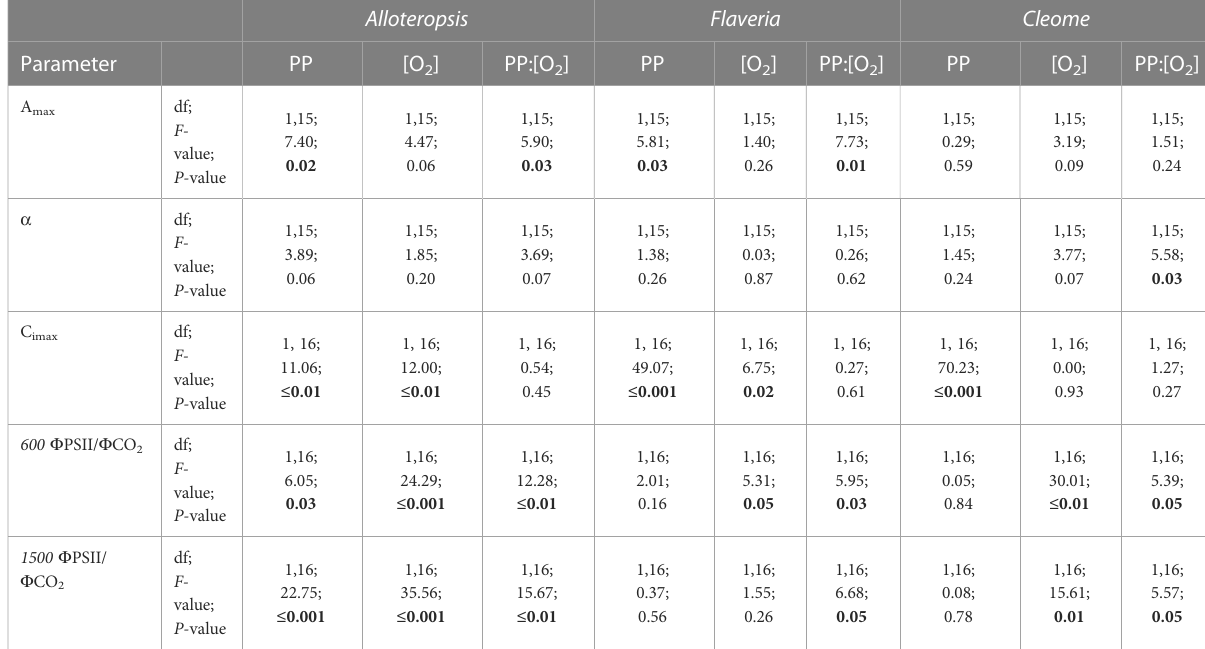
TABLE 2 ANOVA table of modelled light response curve parameters for phylogenetically linked C 3 and C 4 Alloteropsis , Flaveria and Cleome species. Alloteropsis Flaveria